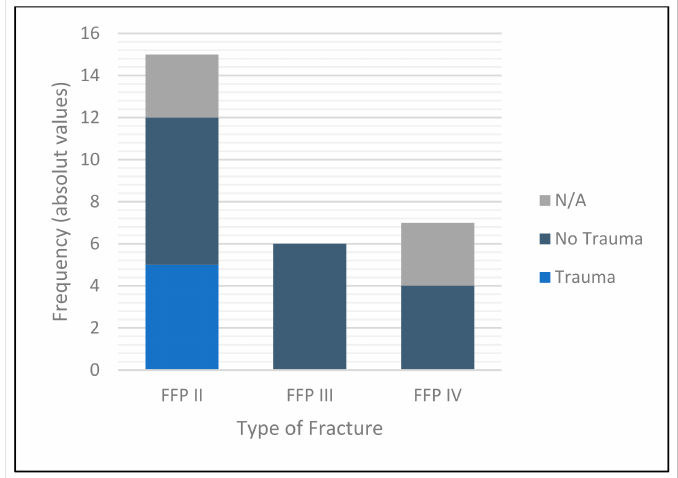
Figure 4. Bar diagram representing fracture classification and mechanism of injury encountered.